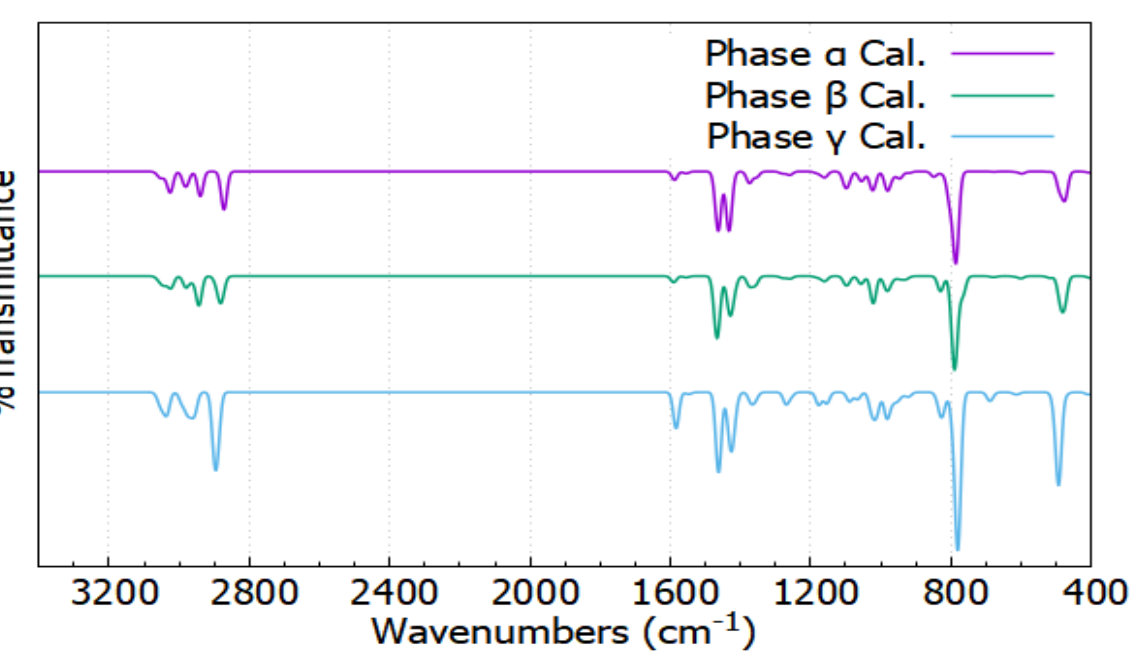
Figure A1. The comparison of calculated FT − IR spectra of α , β and γ phases which are represented by purple, green and blue colored curves, respectively.